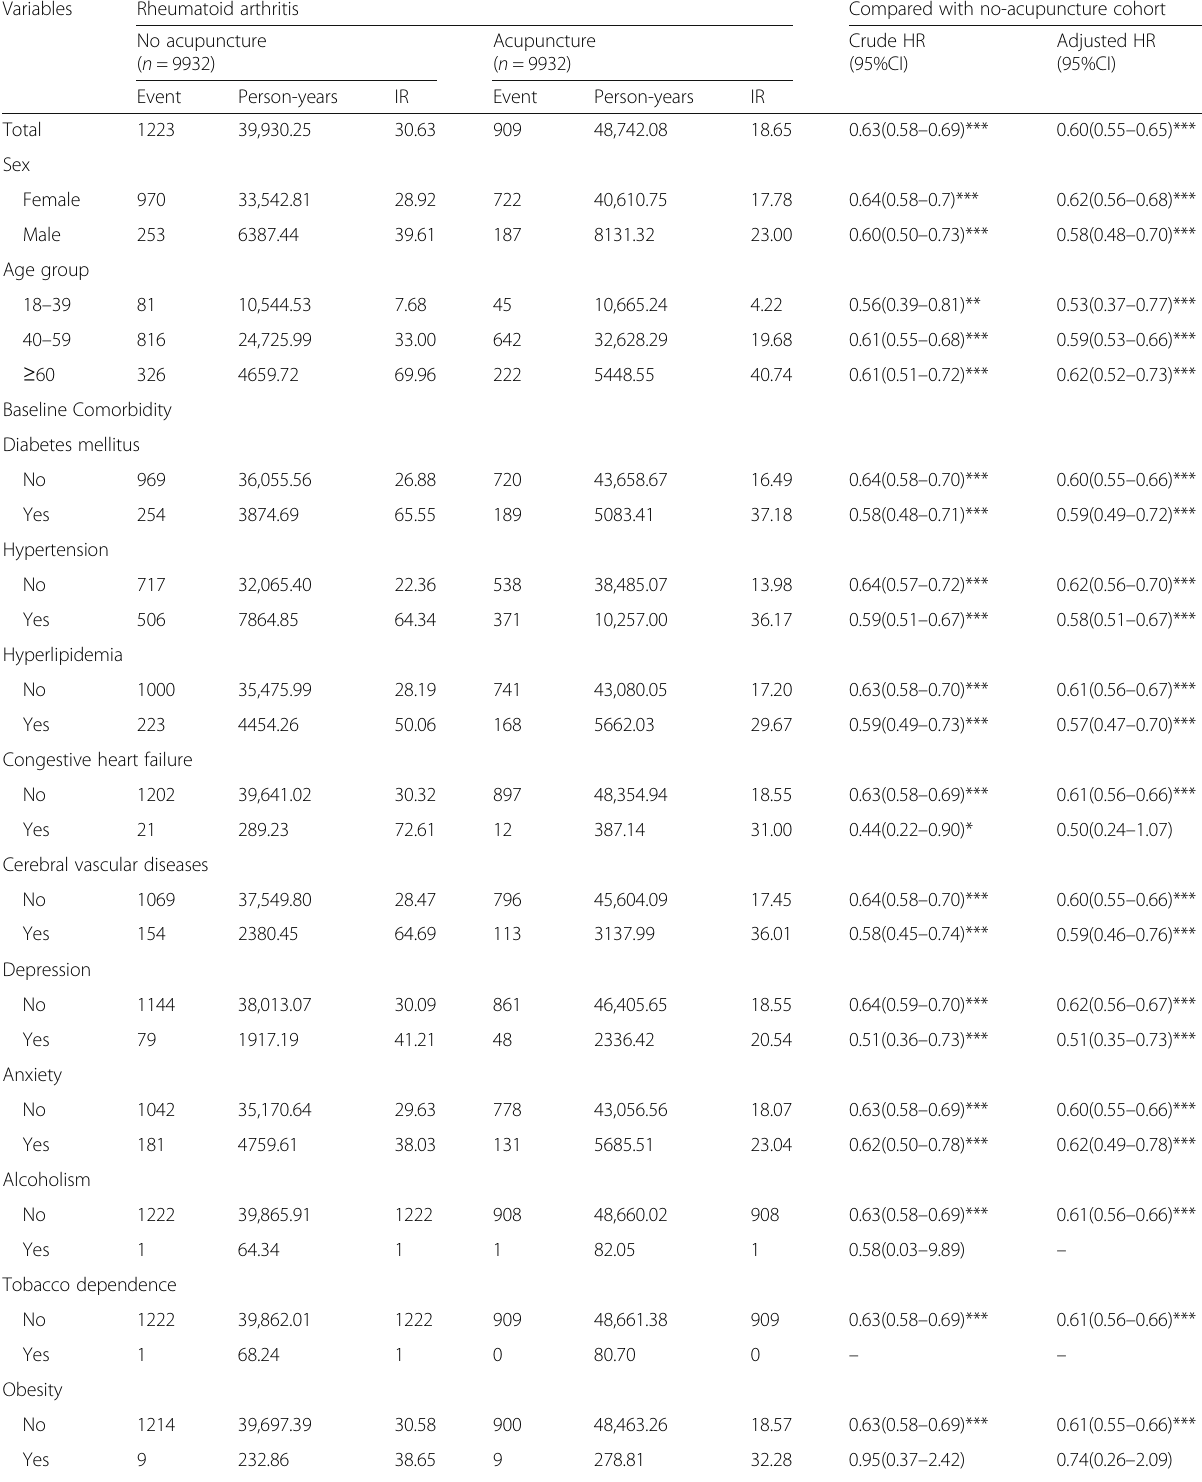
Table 3 Incidence rates, hazard ratio and confidence intervals for coronary heart disease in rheumatoid arthritis patients who did or did not receive acupuncture treatment, stratified by sex, age, comorbidity and drug